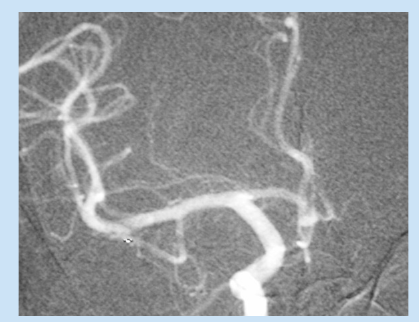
Fig .1b. Selective right internal carotid digital sub- traction arteriogram shows normal patency of the distal right ICAand adjacent